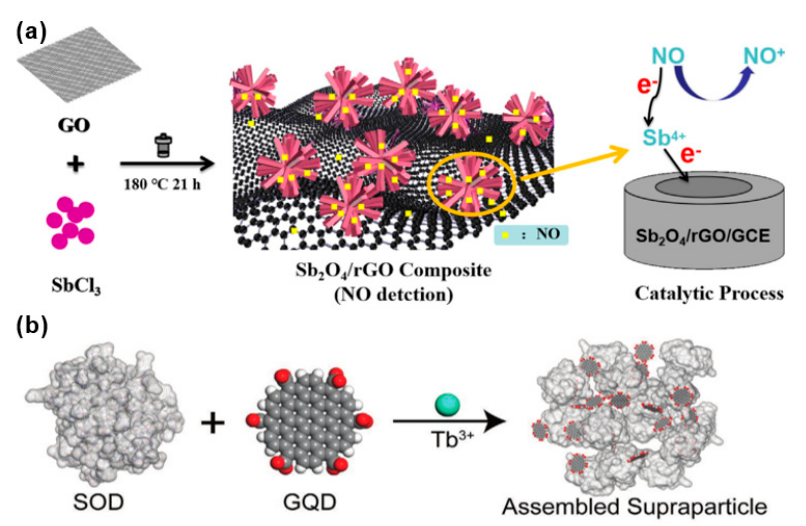
Figure 4. ( a ) Synthetic route of antimony tetroxide (Sb 2 O 4 ) nanoflower/rGO nanocomposite [57]. Copyright (2021), used with permission from Elsevier. ( b ) Schematic diagram of the process of monodisperse superparticles (SPs) prepared by coordinating bridged graphene quantum dots (GQDs) and superoxide dismutase (SOD) using terbium ion as metal [59]. Copyright (2021), used with permission from Wiley.